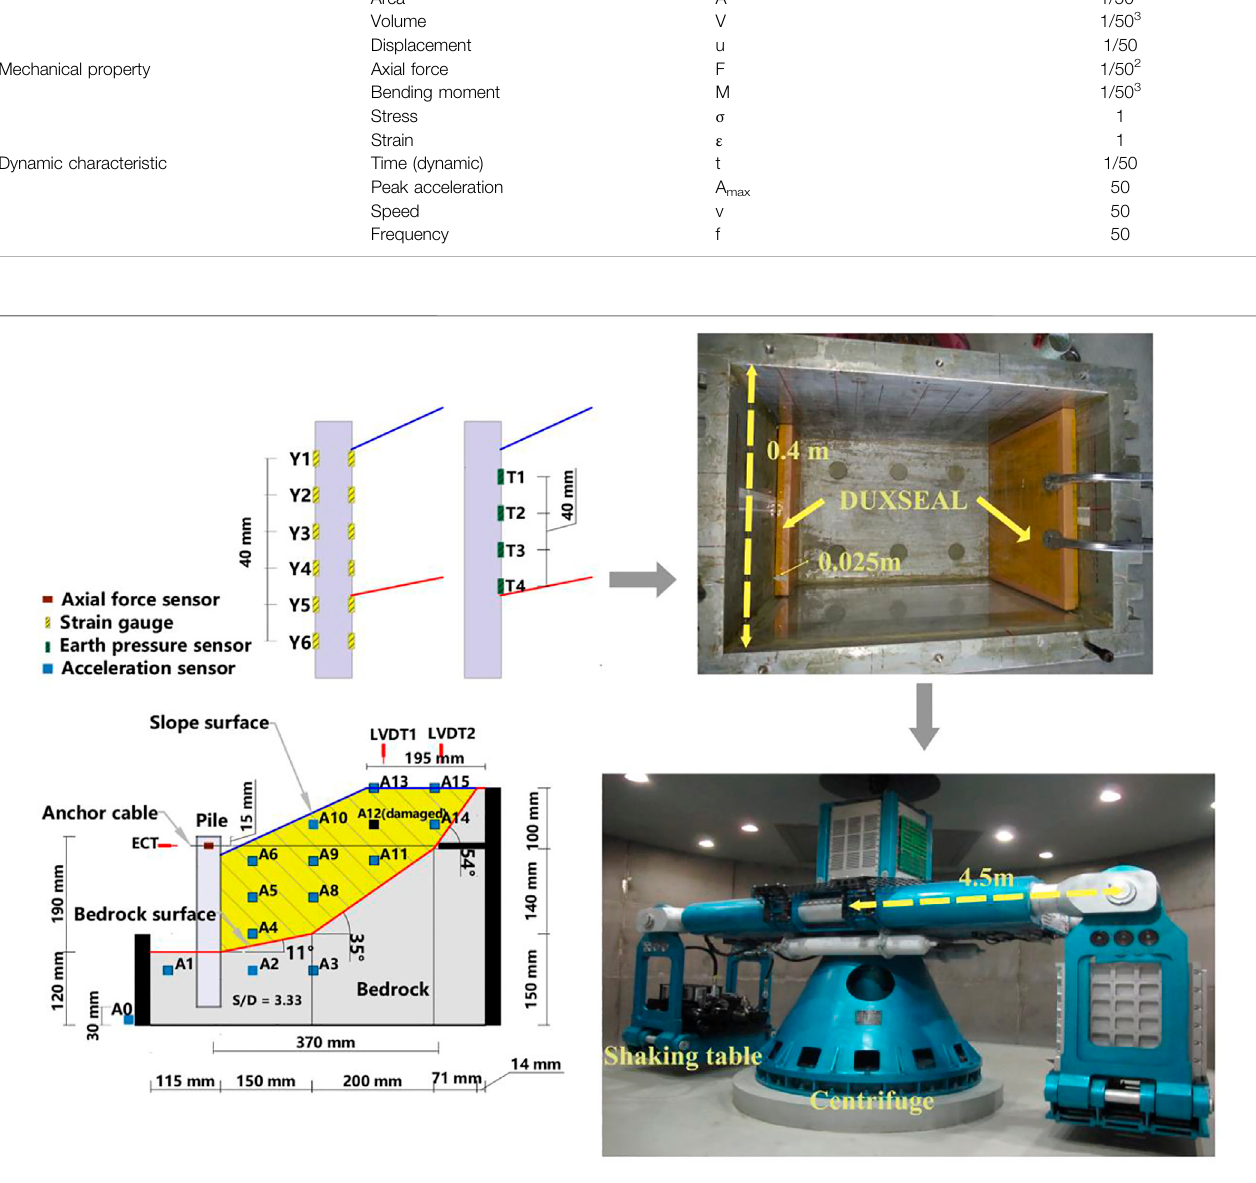
FIGURE 1 | Model structure and sensor